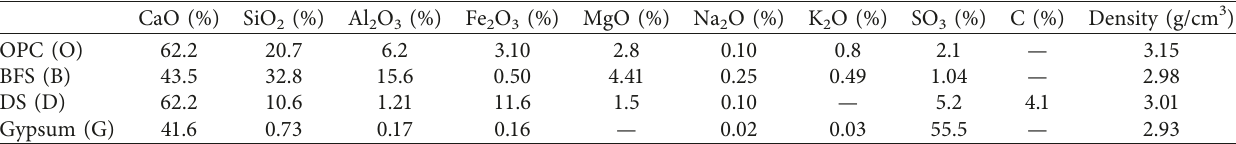
Table 1: Chemical compositions.